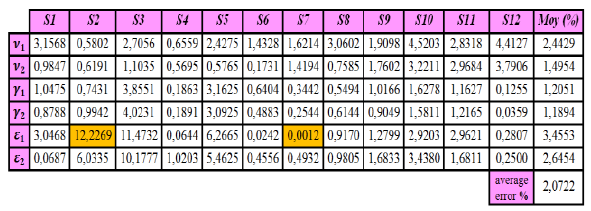
TABLE IV. A VERAGE E RROR R ATE F OR E ACH R ETRIEVED P ARAMETER ( WITHOUT IMPACT OF VEGETATION ) Due to the presence of vegetated layer, radar energy suffers a loss. This loss is known as the vegetation attenuation, whose quantity increases significantly depending on the density of the vegetation